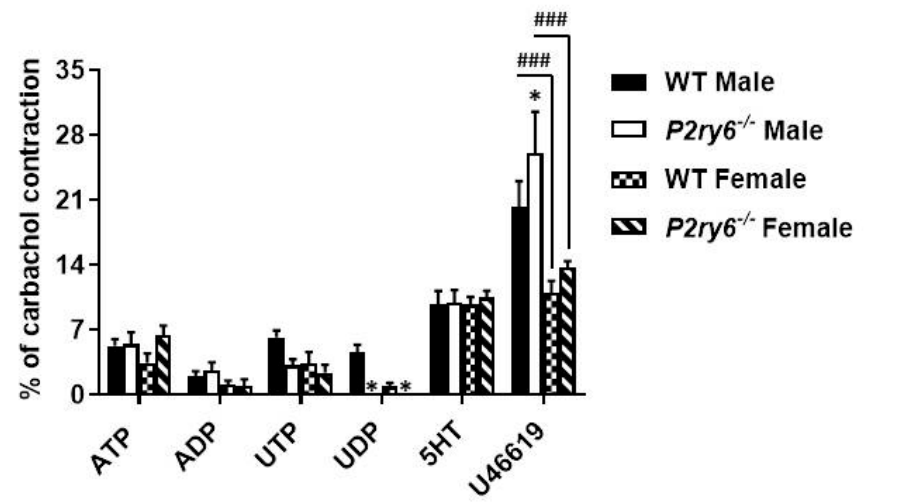
Figure 6. Contractile effect of extracellular nucleotides on male and female strips from P2ry6 − / − mouse bladders. Data are presented as the mean ± SEM of 15 contraction experiments with strips from WT (wild type) and P2ry6 − / − (P2Y 6 receptor knock-out) male bladders and 10 with strips from WT and P2ry6 − / − female bladders. One symbol p < 0.05, 3 symbols p < 0.001. * Contraction of P2ry6 − / − bladders compared to WT; # Contraction of male strips compared to female strips of the same genotype. ATP, ADP, UTP, and UDP were used at the concentration of 100 µM, 5HT at 10 µM, and U46619 at 100 nM.